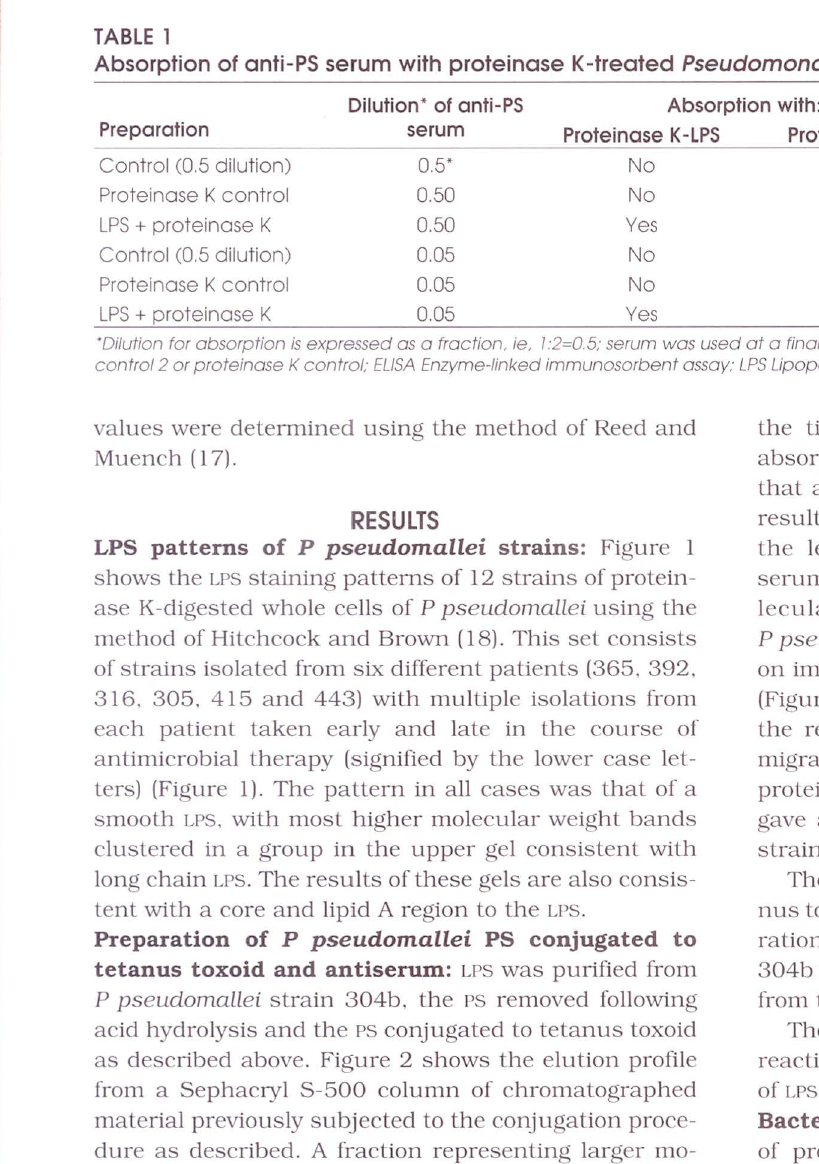
Absorption of anti-PS serum with proteinase K-treated Pseudomonas pseudomallei LPS Dilution• of anti-PS Absorption with: Ratio of absorbed